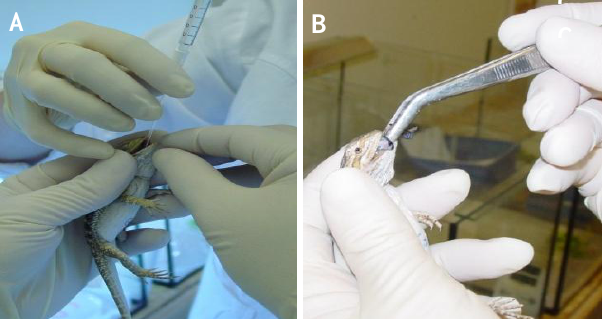
Figure 2. Transmission study of IIV in bearded dragons ( Pogona vitticeps ). ( A ) Administering virus preparate with an intra-gastric tube. ( B ) Force feeding with cricket-preparation. Note the bluish iridescence of the cricket preparate at the tip of the